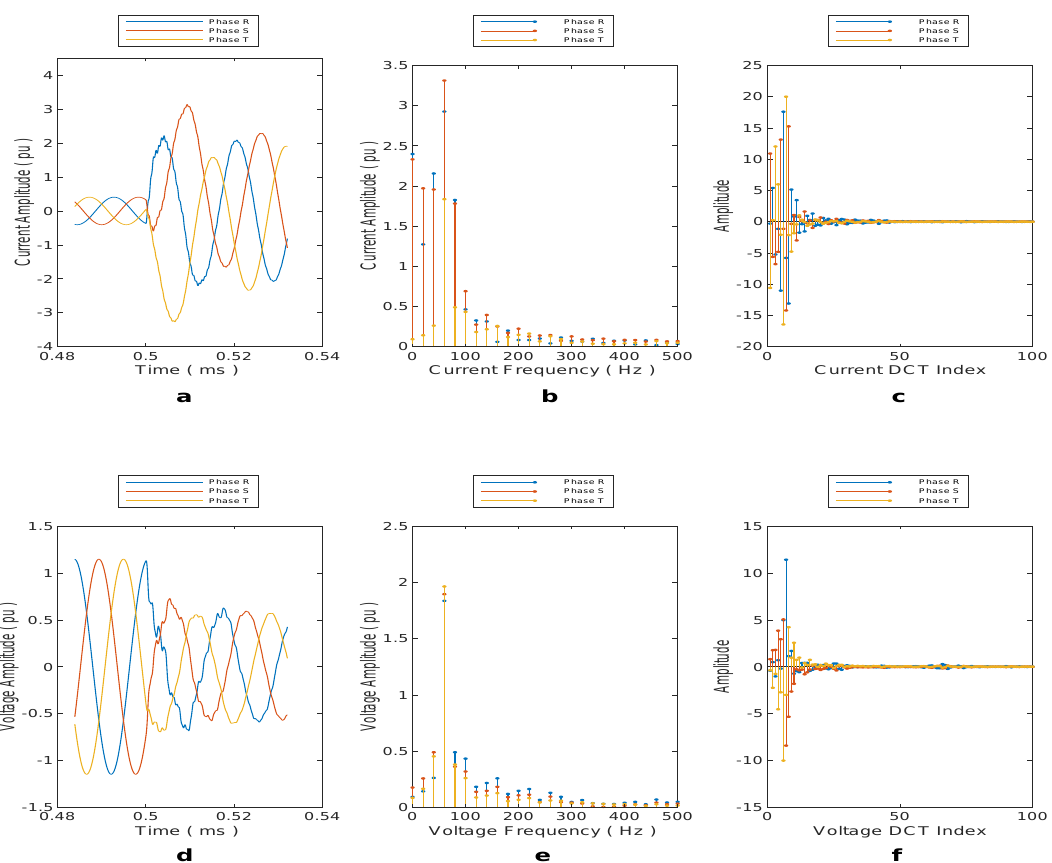
Figure 4. ( a ) Time signals of current at bus 4, ( b ) frequency spectrum of current at bus 4, ( c ) DCT index of current at bus 4, ( d ) Time signals of voltage at bus 4, ( e ) frequency spectrum of voltage at bus 4, ( f ) DCT index of voltage at bus